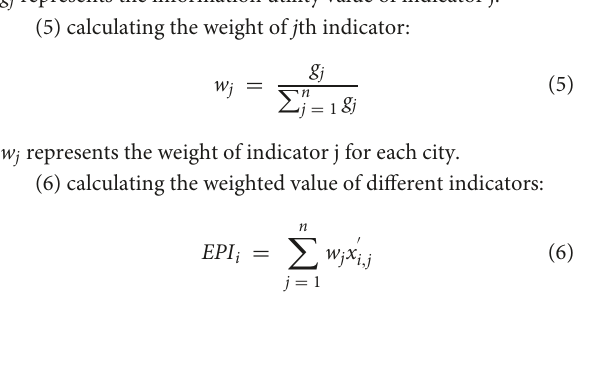
g j represents the information utility value of indicator